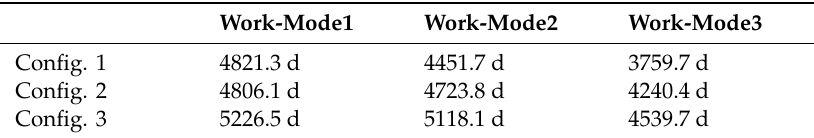
Figure 26. Life prediction of the FS with Configuration 3 in di ff erent work modes. Table 6. Life prediction of FSs with di ff erent